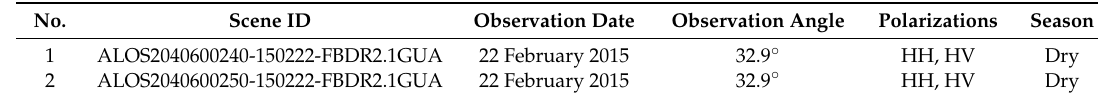
Table 1. ALOS-2 SAR data used in this research.